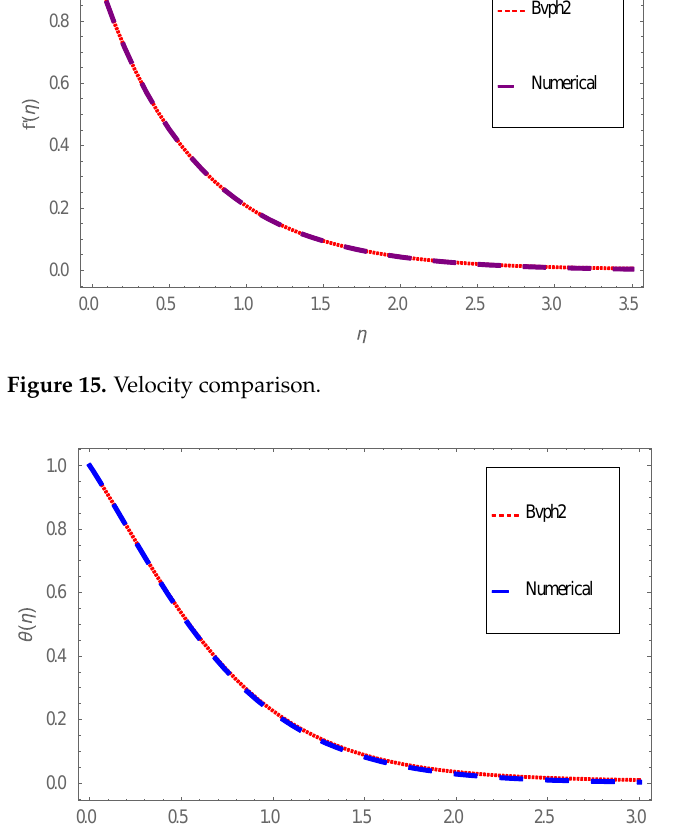
Figure 17. Error decay for the 10th-order approximation. Table 2. Comparison of (Au-Cu)/Ethylene hybrid nanofluid velocity. 𝛈